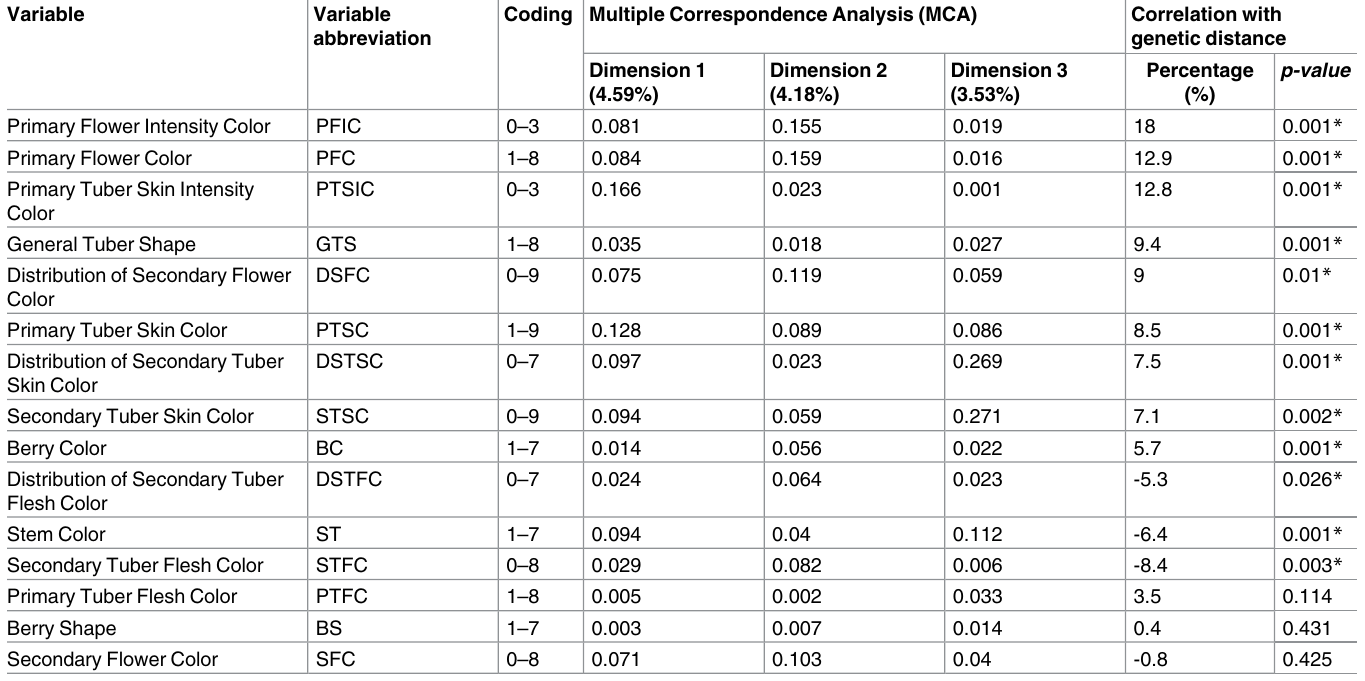
Table 2. Results of morphological analysis of qualitative characters of Andigena population of the